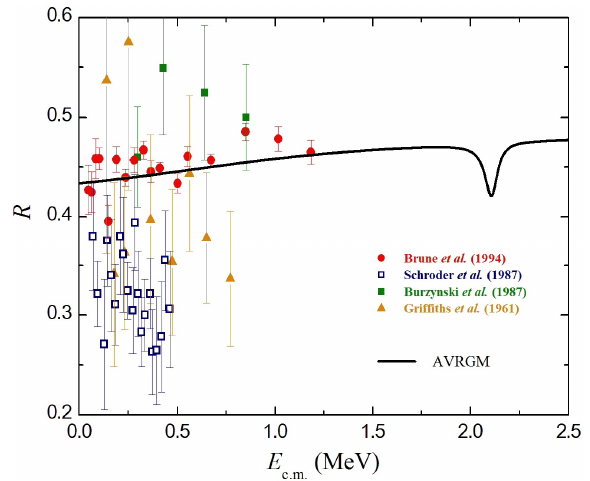
Fig. 4. Energy dependence of the 3 H( α , γ ) 7 Li branching ratio